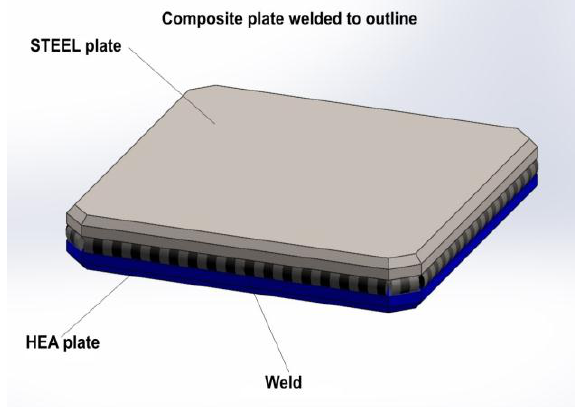
Figure 1. Composite plate welded by explosion.